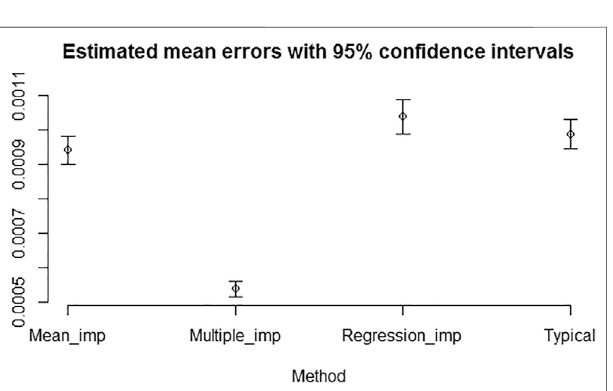
FIGURE 4 | Estimated mean errors with 95% con fi dence intervals for computing Brier scores with 10% individual missing values introduced completely at